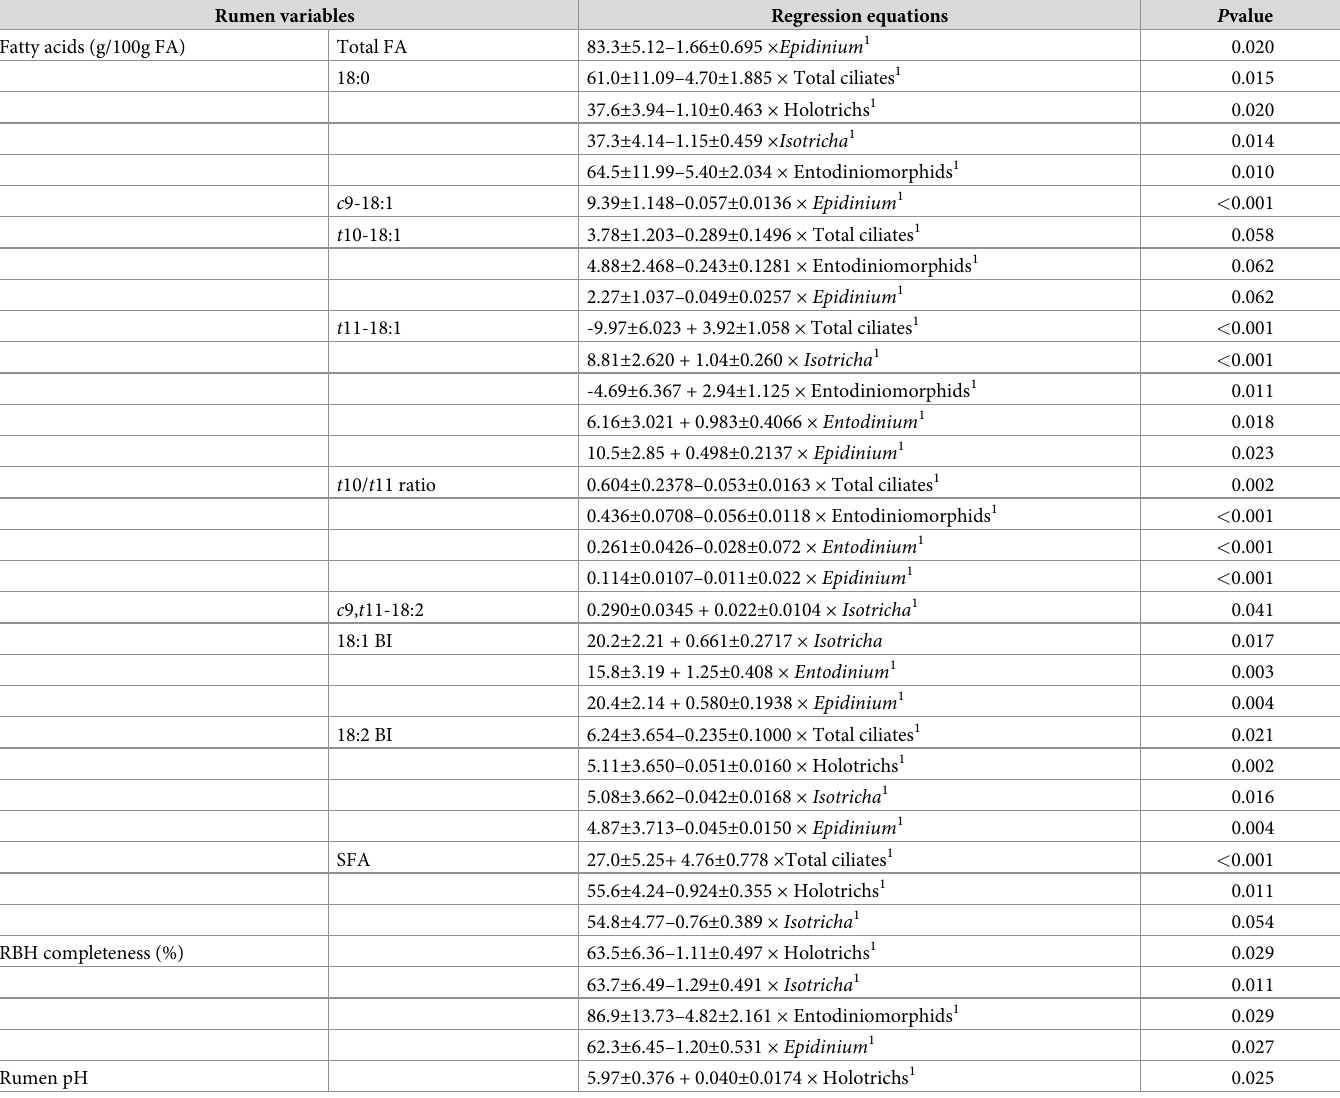
Table 5. Significant linear regression between rumen ciliates (log 10 cells/ml) and rumen variables. Rumen